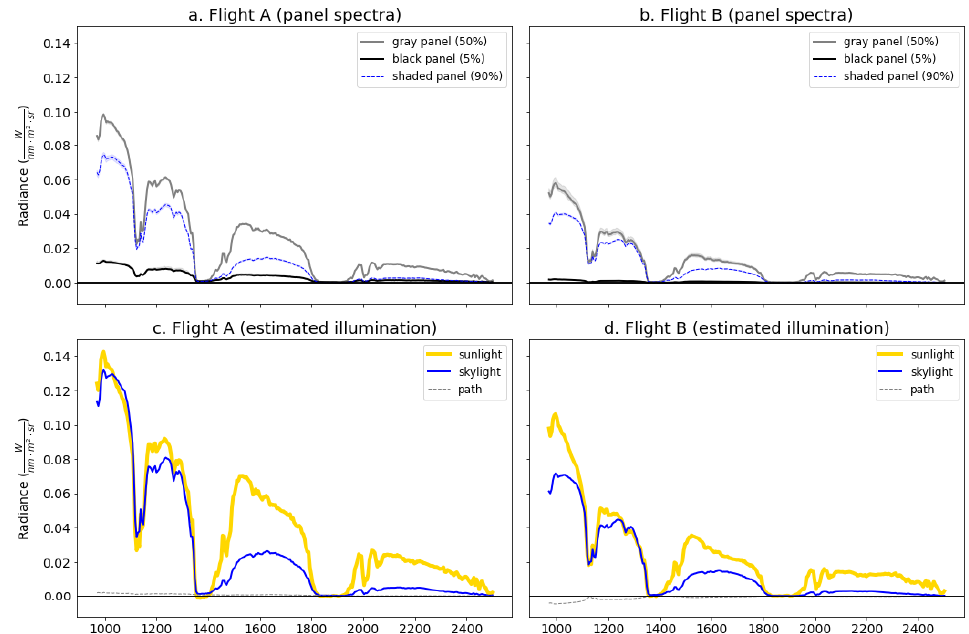
Figure 7. Measured calibration panel spectra ( a , b ) for each flight and derived illumination source spectra ( c , d ). These spectra were used to model and correct for illumination effects (atmospheric and topographic) separately in each flight. Note that the path radiance is essentially negligible, as expected due to the short sensor – target distance, but that skylight accounts for 25% to 50% of the total illumination during both flights.